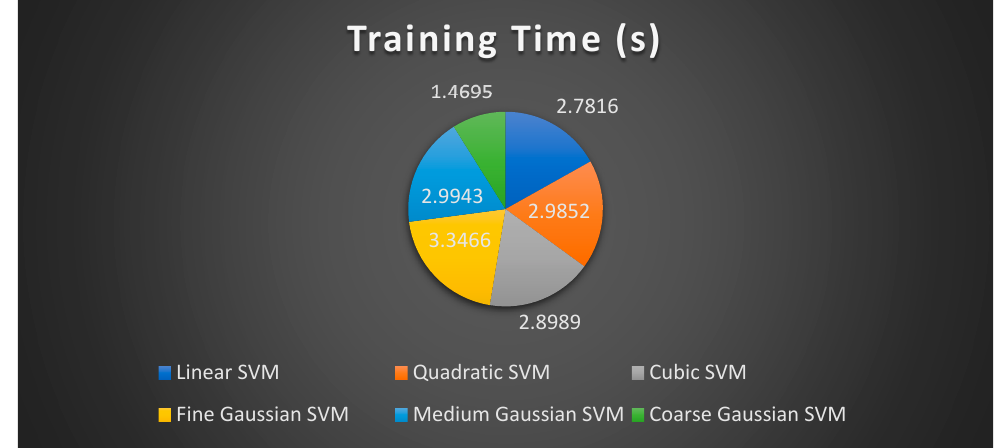
Figure 8. Training time of 550 Features.